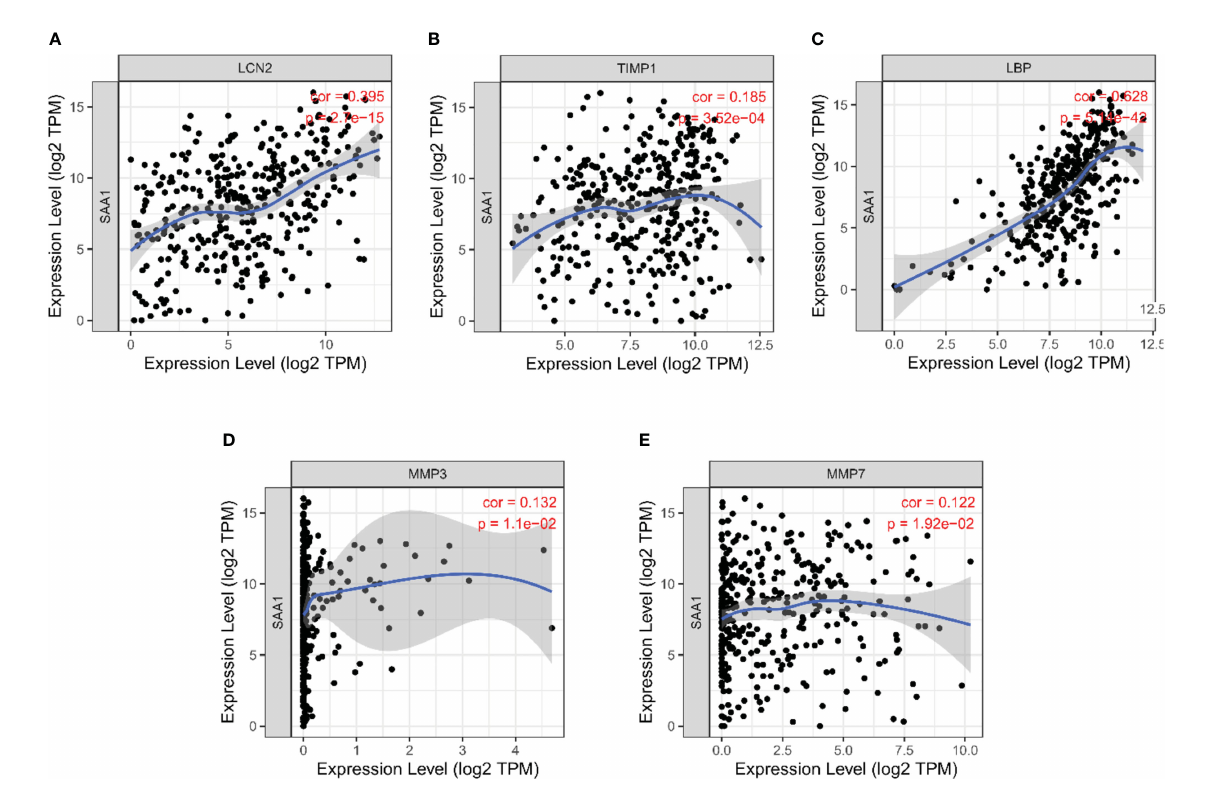
FIGURE 7 Correlation analysis between SAA1 expression level and co-expression genes in HCC based on Tumor Immune Estimation Resource (TIMER) database. (A) Correlation between SAA1 and LCN2 ( r = 0.395; P < 0.001). (B) Correlation between SAA1 and TIMP1 ( r = 0.185; P < 0.001). (C) Correlation between SAA1 and LBP ( r = 628; P < 0.001). (D) Correlation between SAA1 and MMP3 ( r = 0.132; P < 0.05). (E) Correlation between SAA1 and MMP7 ( r = 0.122; P <